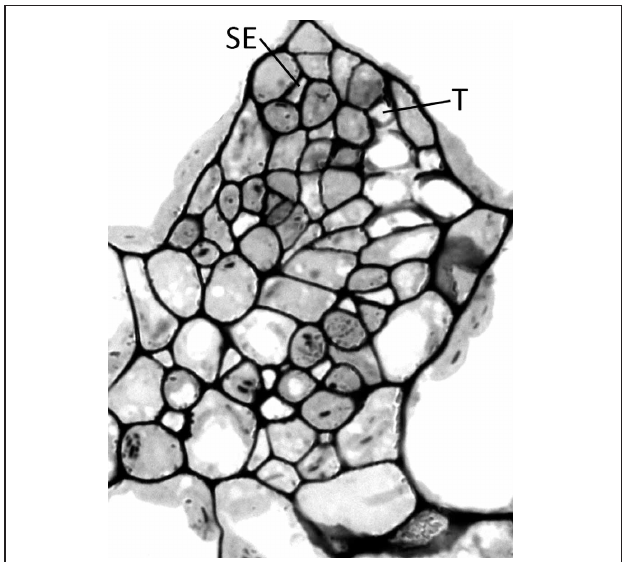
FIGURE 4 | Cross-section of a minor loading vein from the Swedish ecotype of A. thaliana grown under cool (14 ◦ C leaf temperature) and high light (1000 µ mol photons m − 2 s − 1 ) conditions, illustrating the presence of phloem tissue beside and above the tracheids. This vein possesses 13 sieve elements and 6 tracheids, with SE and T indicating the uppermost sieve element and tracheid, respectively.